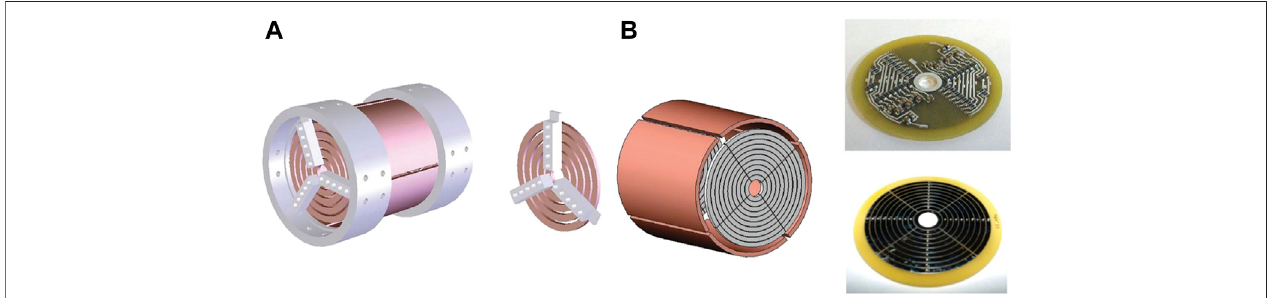
FIGURE4| Noveldesignsoftheclosed-cylindricalFT-ICRcell. (A) DesignoftheTREC. AdaptedwithpermissionfromWeisbrod,C.R.,Kaiser,N.K.,Skulason,G. E. and Bruce, J. E. (2008). Anal. Chem. 80, 6,545 – 6,553 (Weisbrod, et al., 2008). Copyright 2008 American Chemical Society; (B) Design of the eTREC. Adapted with permissionfromWeisbrod,C.R.,Kaiser,N.K.,Skulason,G.E.andBruce,J.E.(2010).Anal.Chem.82,6,281 – 6,286(Weisbrod,etal.,2010).Copyright2010American Chemical Society.